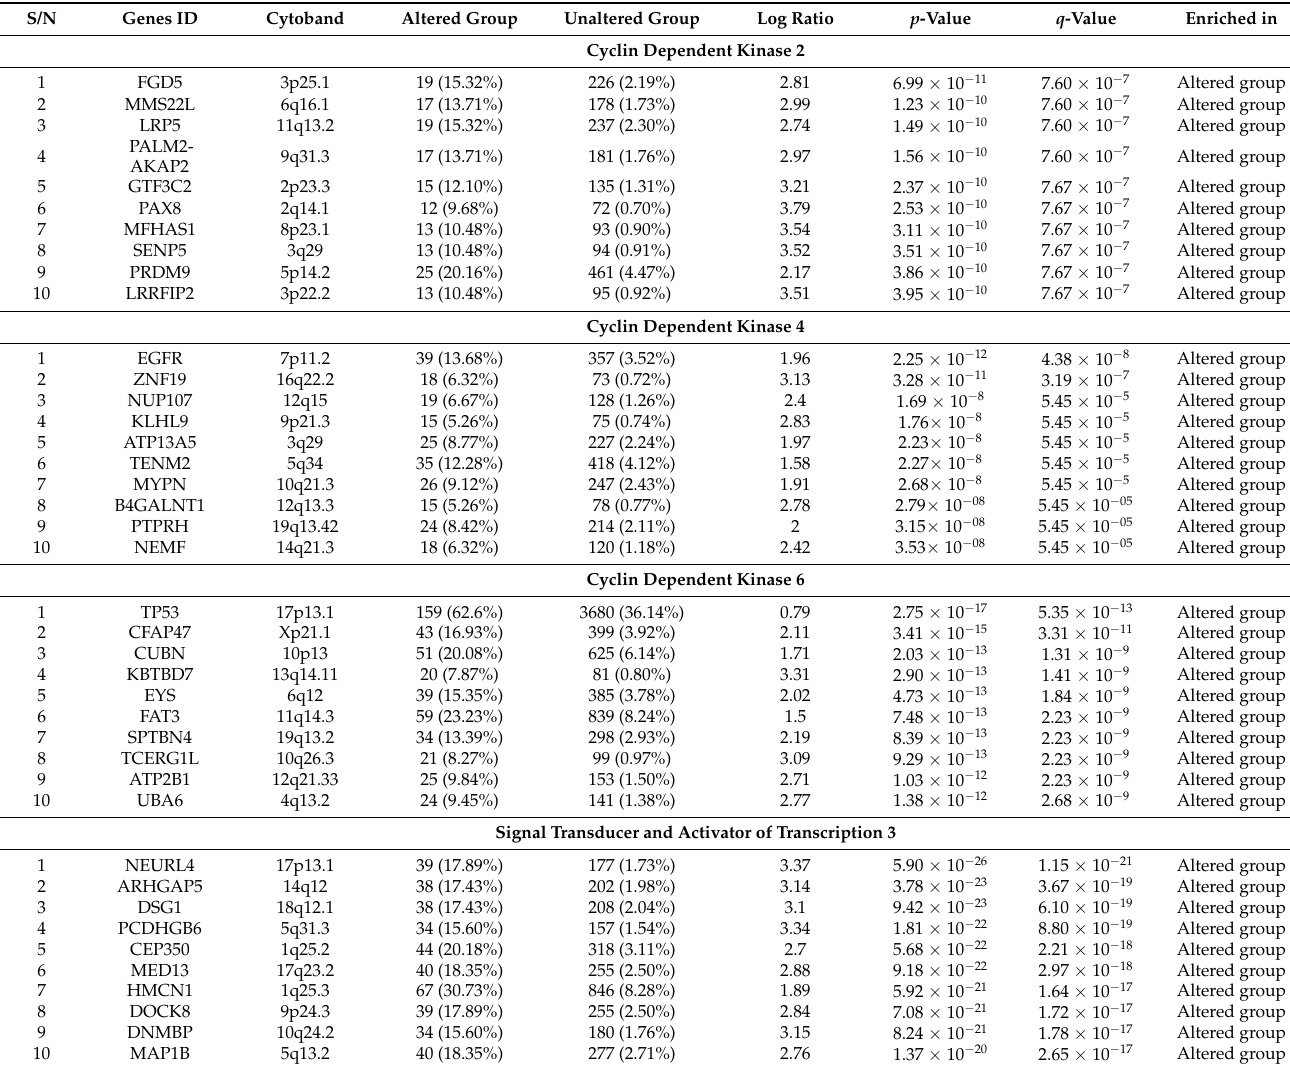
Table 3. Co-occurrence of gene alteration in cancer cohorts with STAT3/CDK2/2/4/6 genetic alteration.